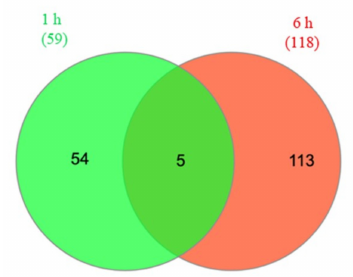
Figure 5. Venn diagram showing the overlap between genes di ff erentially expressed only in drought-resistant genotypes (DR1 and DR2) genotypes at 1 and 6 h.